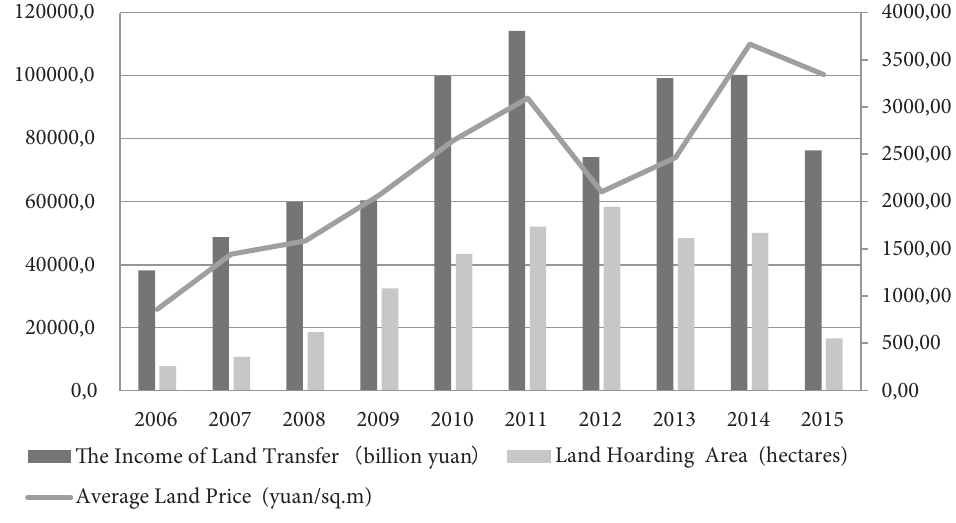
The Income of Land Transfer (cid:15910) billion yuan (cid:15911) Land Hoarding Area (hectares) Average Land Price (yuan/sq.m) Figure 1. China’s average land price, land income, and land hoarding from 2006 to 2015 Note: Data sources: China Statistical Yearbook of Land and Resources (2007–2016), all the data is got from open resources, and the copyright is permitted